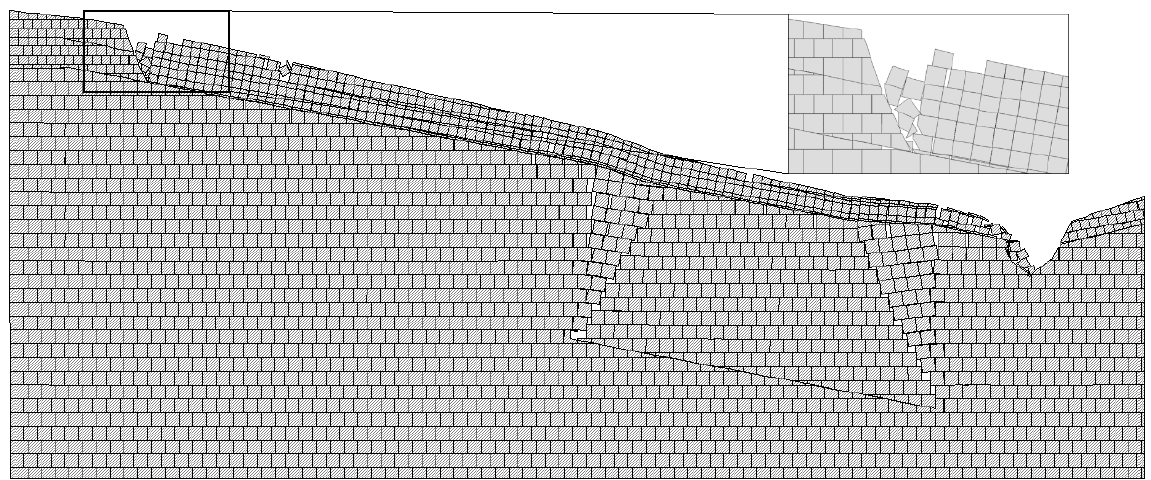
Figure 7. Iterative 200,000-step numerical simulation results.